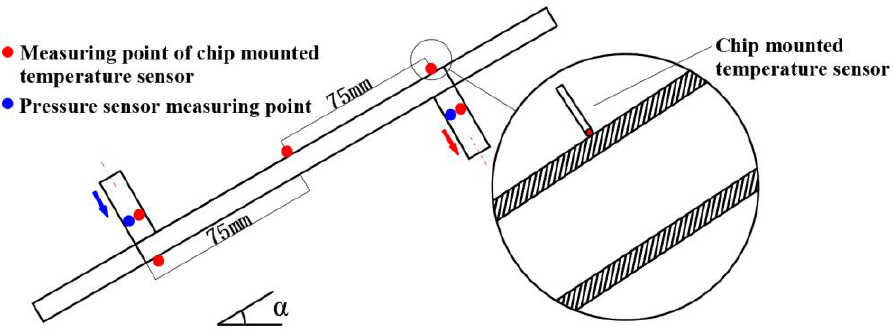
Figure 3. Experimental section measurement point arrangement scheme.